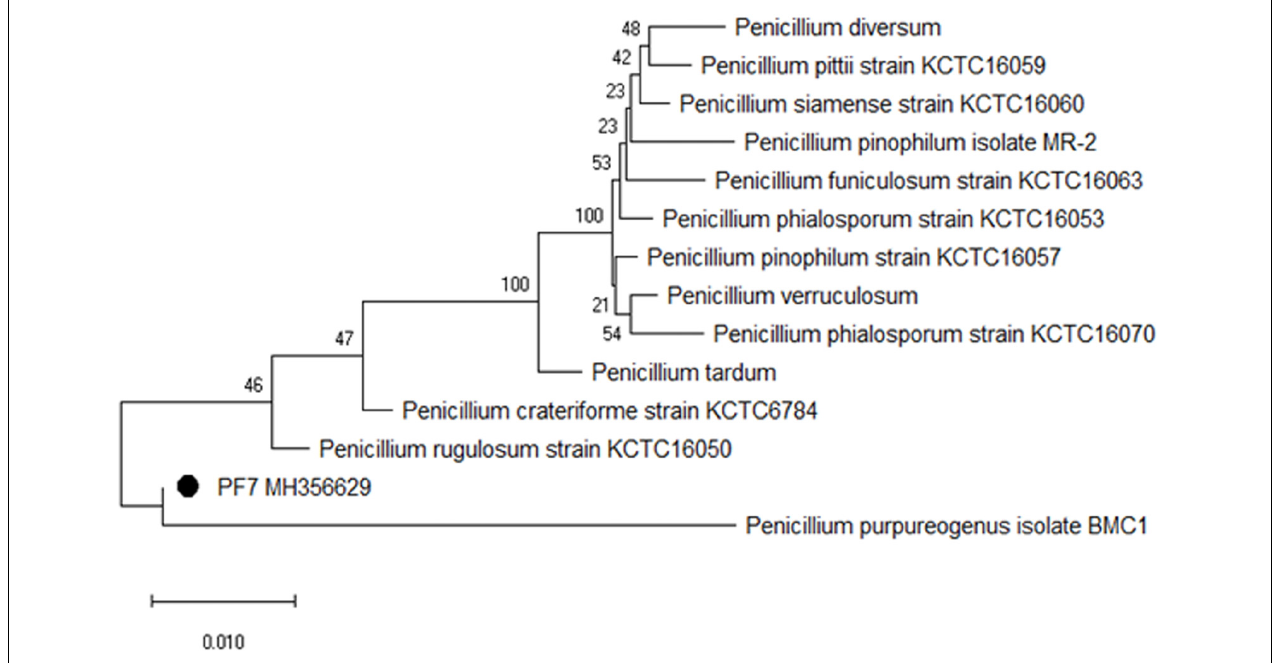
FIGURE 2 | Phylogenetic dendrogram showing the relative position of P. purpurogenum PF7 isolated from rotten wood samples and sequence similarity analysis of 5.8S rRNA.